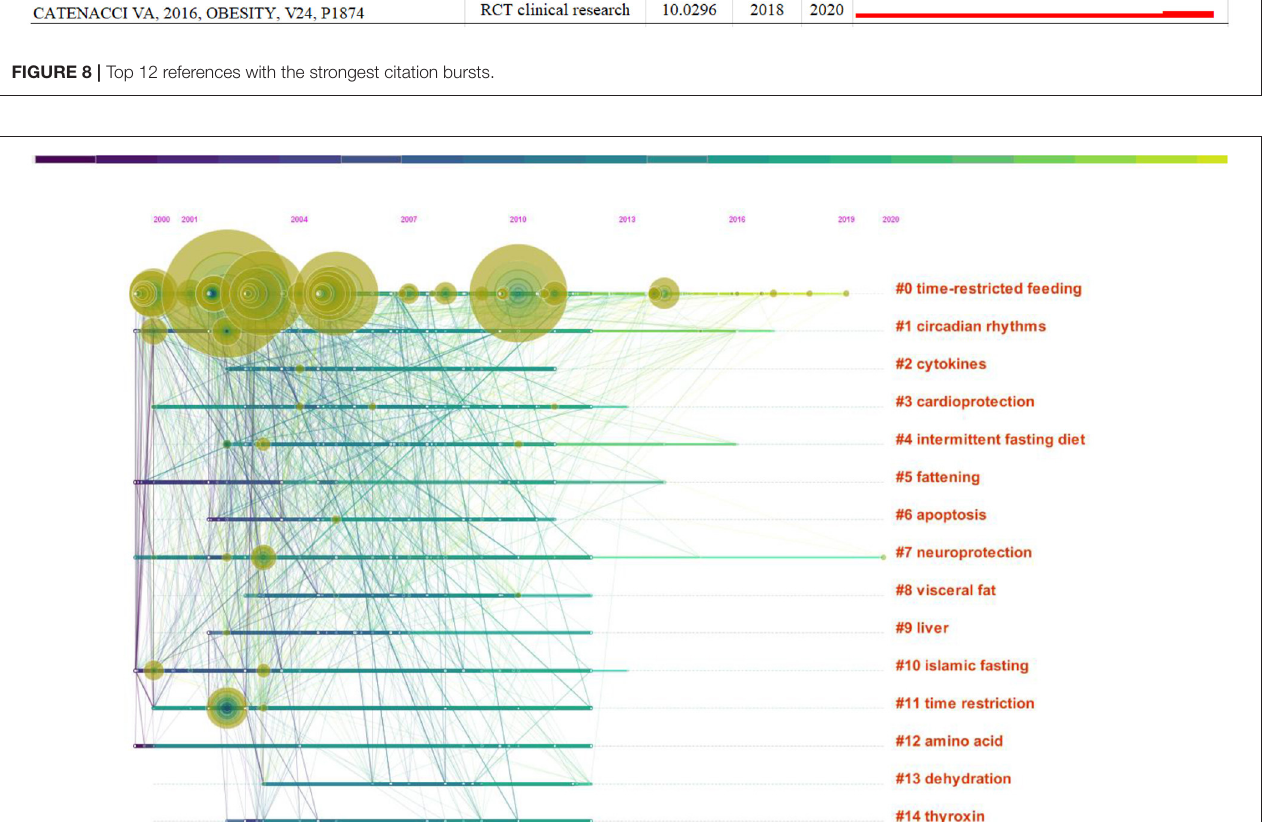
FIGURE 9 | Time-line mapping of keywords in the field of intermittent fasting research